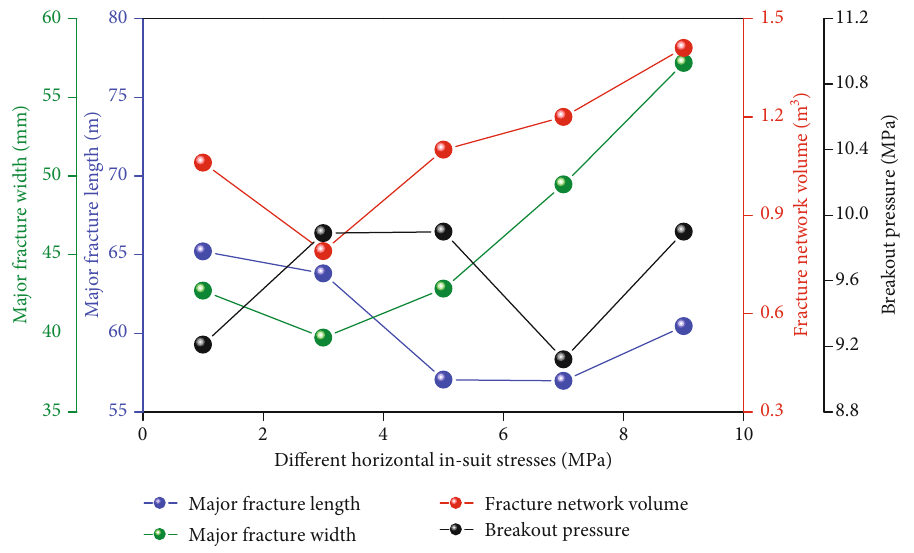
Figure 12: E ff ect of HSD on hydraulic fracture